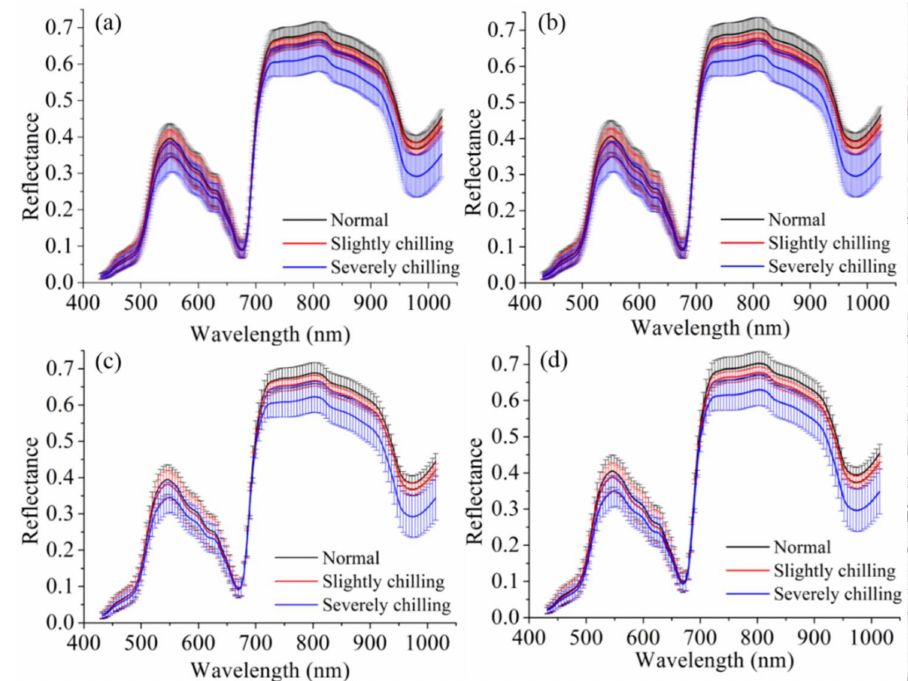
Figure 3. Mean spectra of normal (n = 120), slightly (n = 120) and severely (n = 120) chilling samples at different scanning speeds and spectral resolutions. ( a , b ) were 8 mm/s and 20 mm/s with spectral resolution of 1.25 nm, respectively. ( c , d ) were 8 mm/s and 20 mm/s with spectral resolution of 5.03 nm,